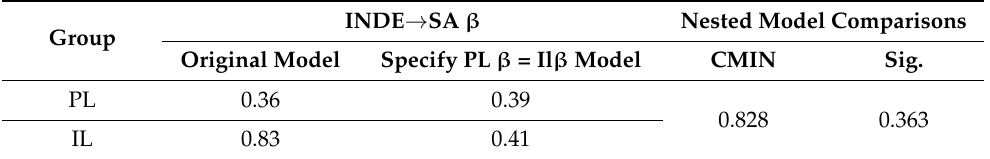
Table 13. Moderating effect